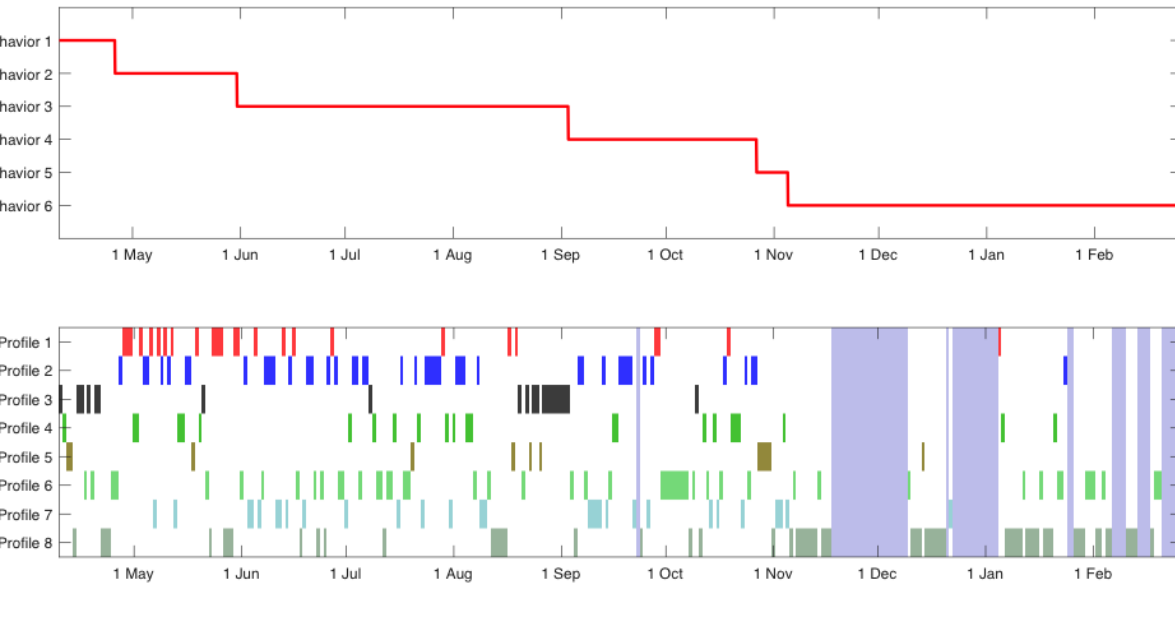
Figure 4. Representation of mobility pattern changes (upper) identified by the technique and corresponding patterns (lower) during study participation of patient